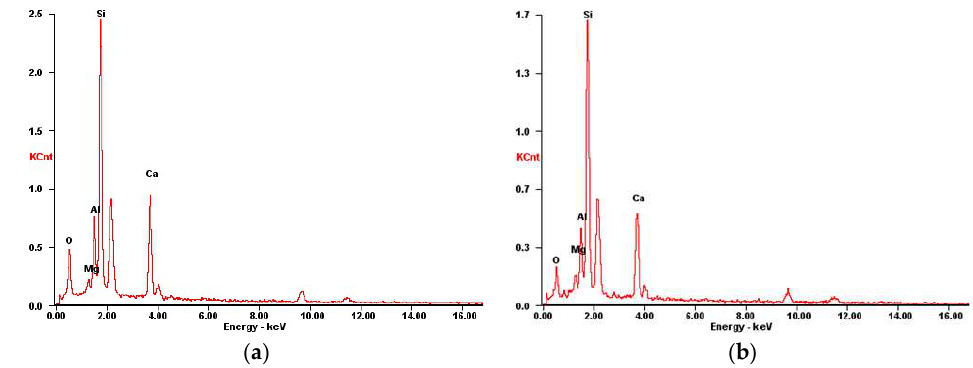
Figure 15. Elemental composition of fibers of G1: ( a ) Before conditioning; ( b ) After accelerated aging at 60 °C for 180 days. (Notes: The peak on the right of Si was Au. GFRP itself does not contain gold elements, and this came from the gold coating for the sample preparation. This element is not listed in the figure.)